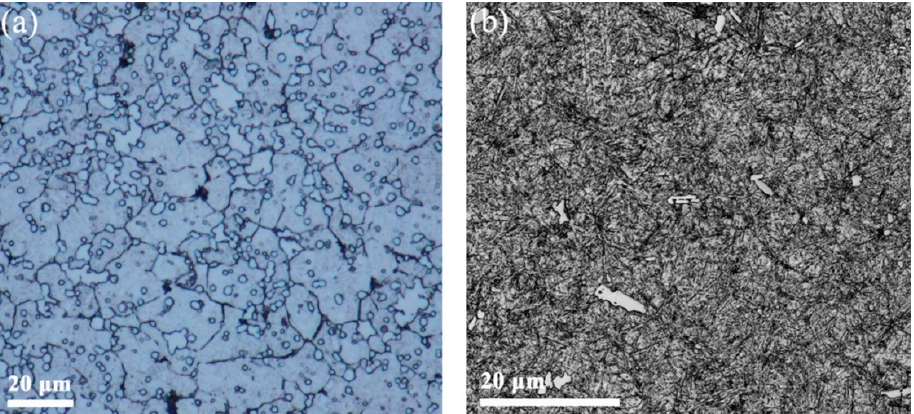
Figure 1. Metallurgical structures of ( a ) 9Cr18 stainless steel and ( b ) M50 bearing